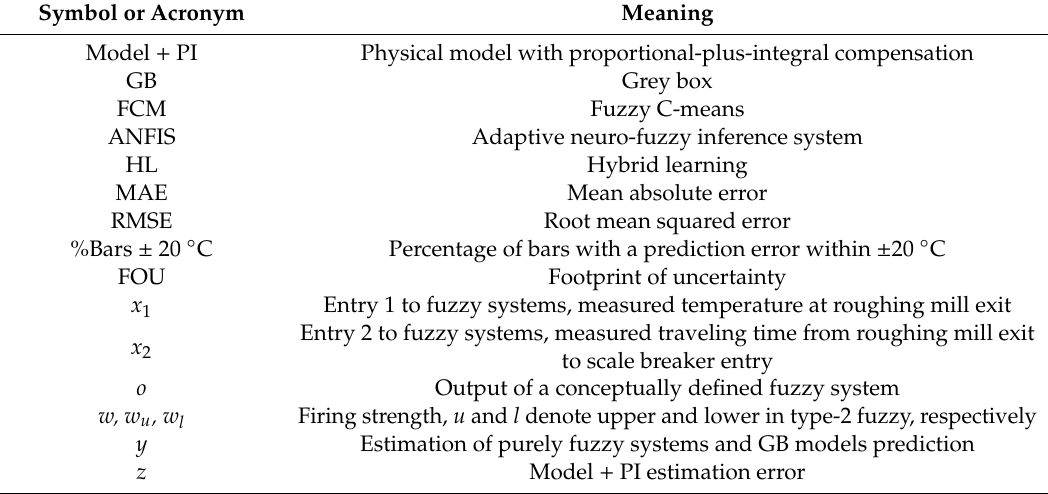
Table 1. List of symbols and